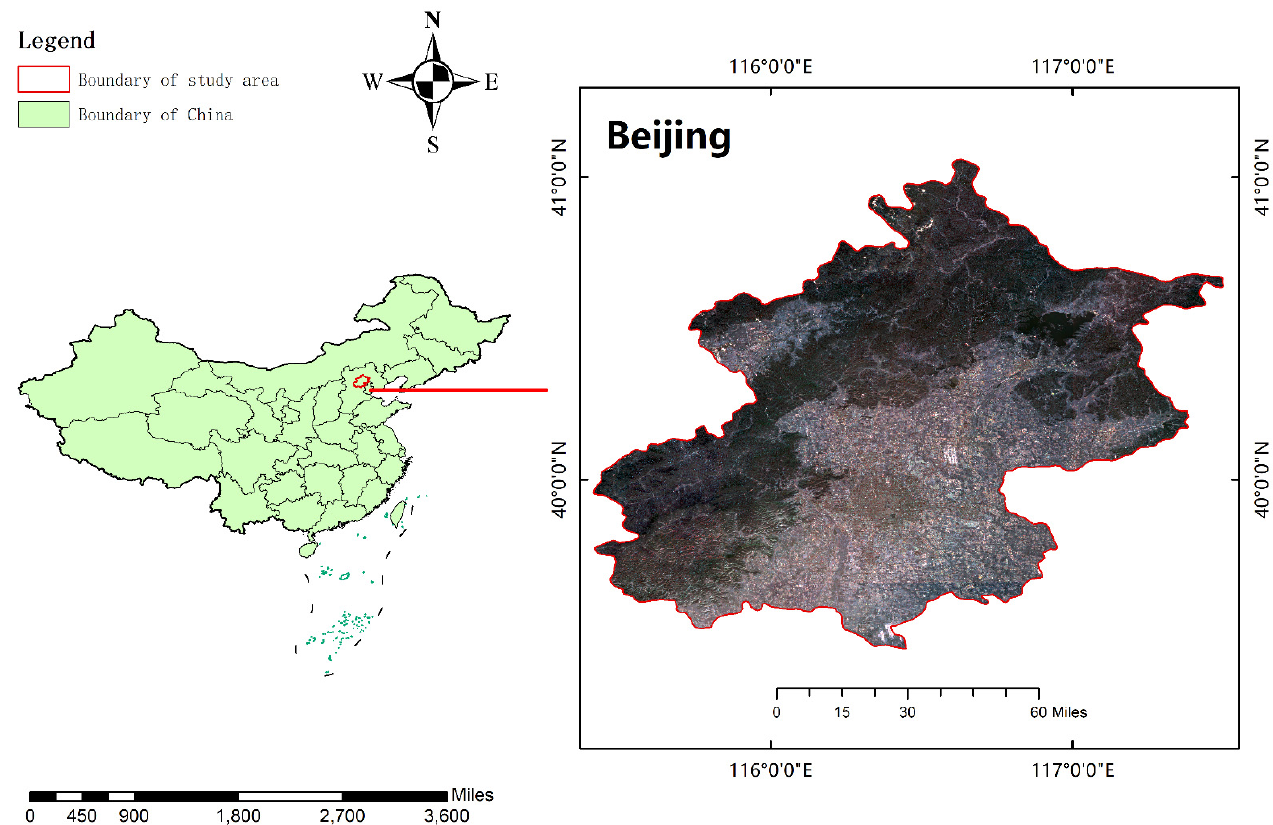
Figure 1. Location of Beijing and the Sentinel-2 remote sensing image of Beijing.